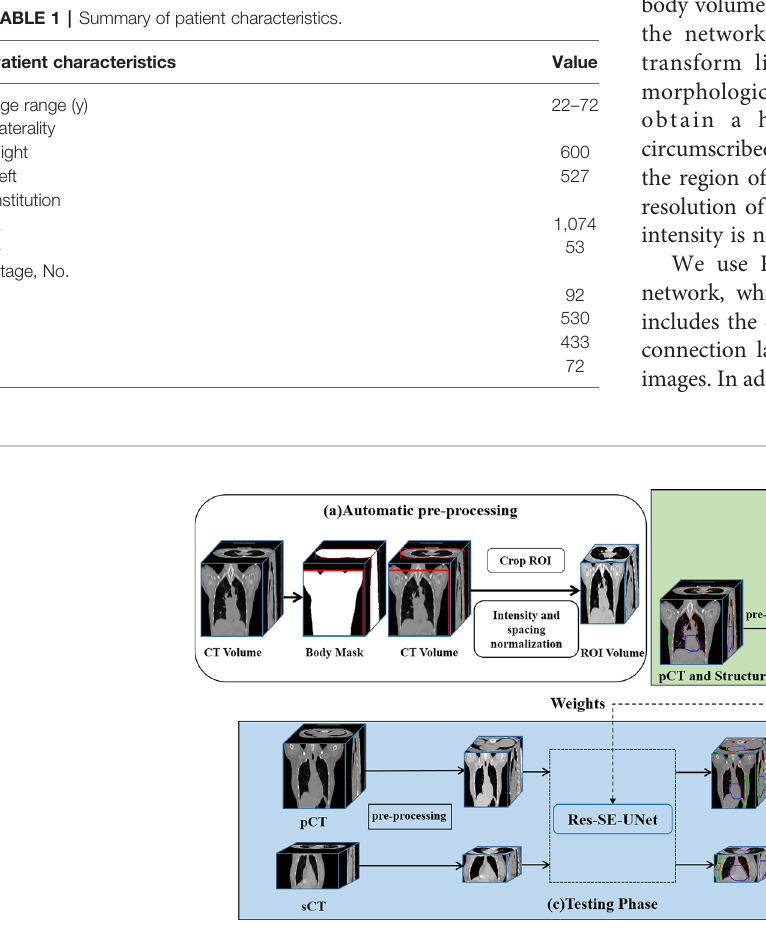
FIGURE 1 | The work fl ow of the automatic delineation model. (A) automatic preprocessing, (B) training phase, (C) testing